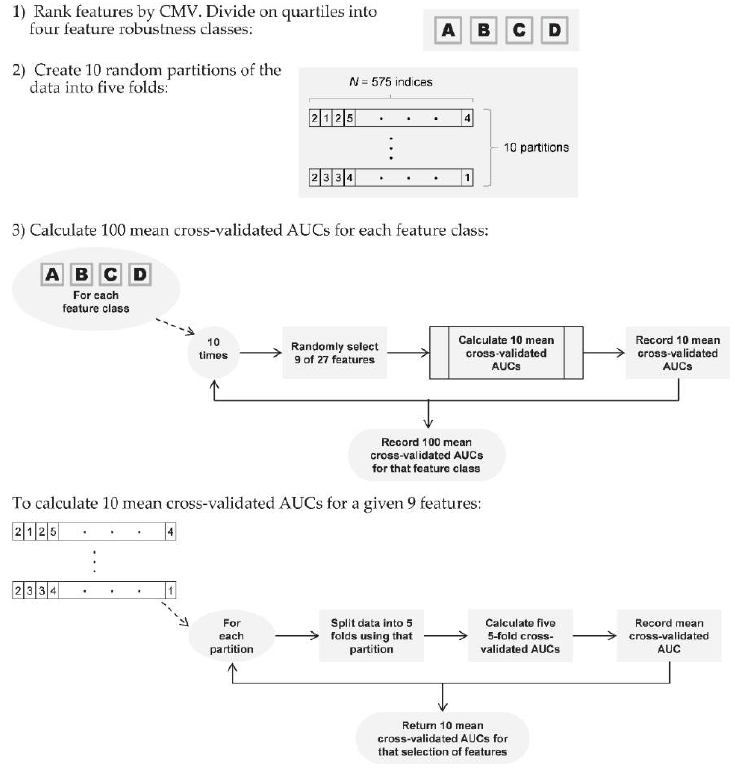
Figure 2. Flow diagram of AUC calculation on case-control data using logistic regression modeling.